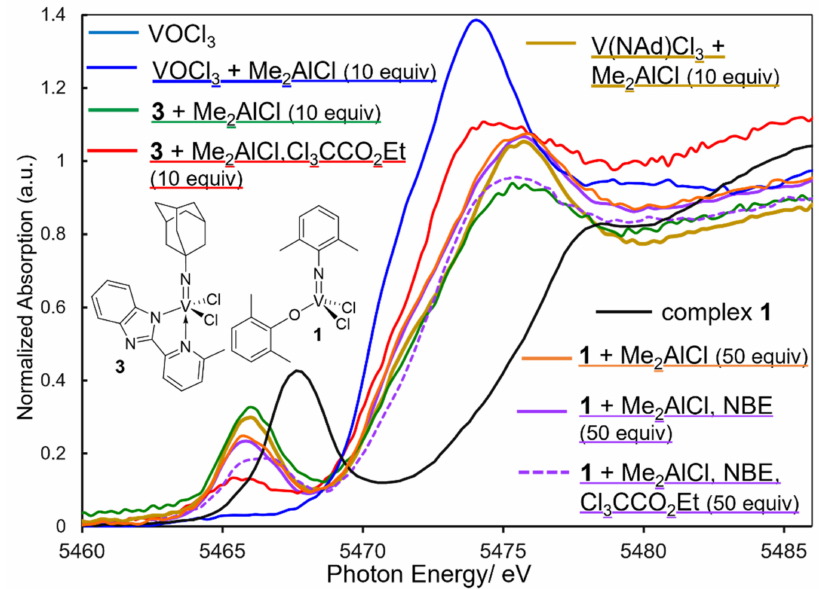
Figure 5. The V K-edge XANES spectra (in toluene at 25 ◦ C) for VOCl 3 , V(NAd)Cl 3 [53], V(NAr)Cl 2 (OAr) ( 1 ) [37], and V(NAd)Cl 2 (L) [ 3 , L = 2-(2 (cid:48) -benzimidazolyl)-6-methylpyridine] [38] in the presence of Me 2 AlCl (and addition of Cl 3 CCO 2 Et,